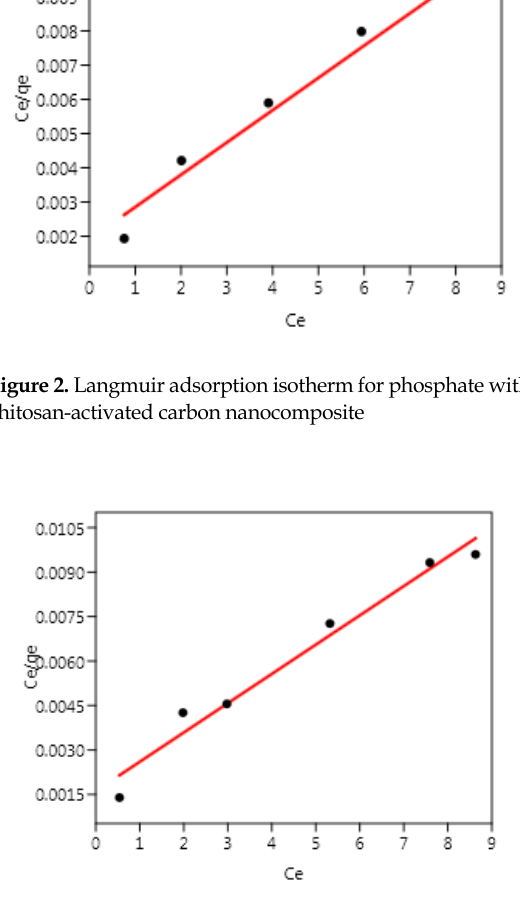
Figure 5. Adsorption isotherm of Freundlich nitrite with